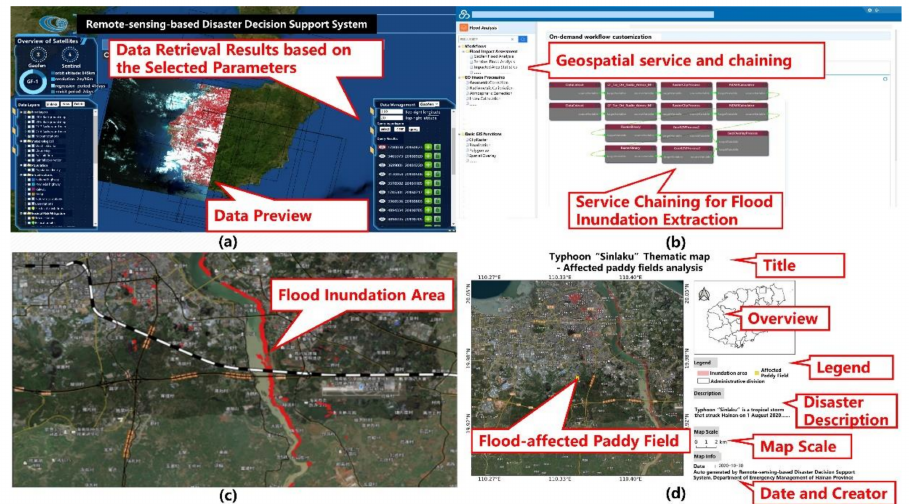
Figure 6. System application on Typhoon “Sinlaku”. ( a ) Remote sensing image resource retrieval; ( b ) Geospatial service chaining for the flood inundation extraction; ( c ) Flood inundation analysis based on Gaofen-1 image (16 m); ( d ) Thematic map of impact paddy field analysis.